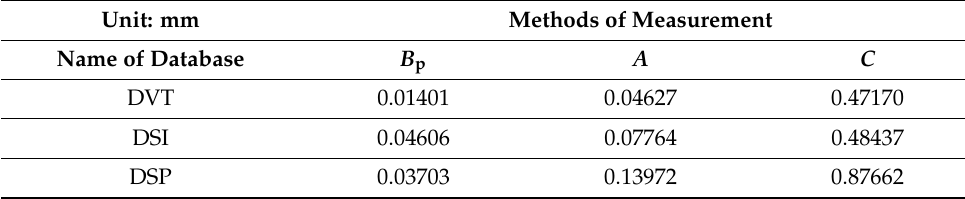
Table 8. Table of cross-section diameter measurement result via STD.